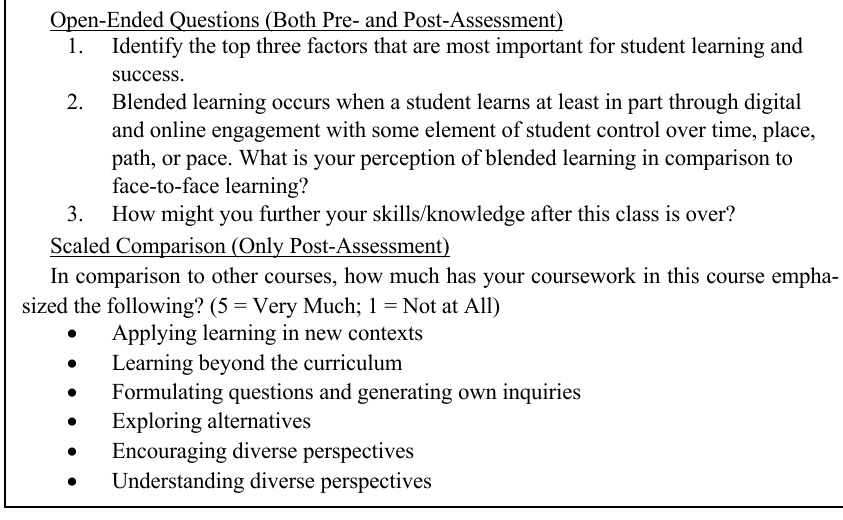
Fig. 2. IRB Approved Pre- and Post-Survey